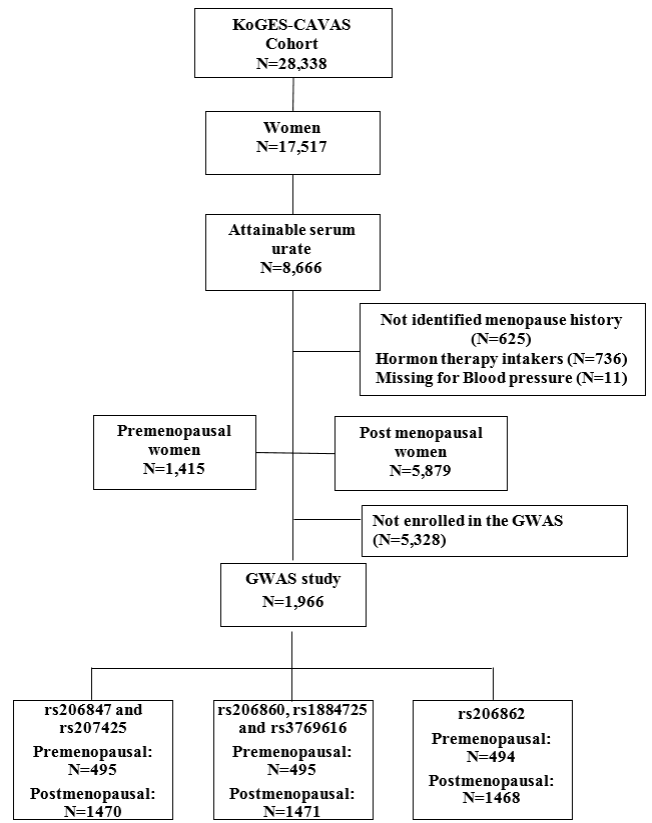
Figure 1. Flow chart of study populations in the KoGES-CAVAS cohort. Abbreviations: KoGES-CAVAS, Korean Genome and Epidemiology Study on Atherosclerosis Risk of Rural Areas in the Korean General Population; GWAS, genome wide association study.